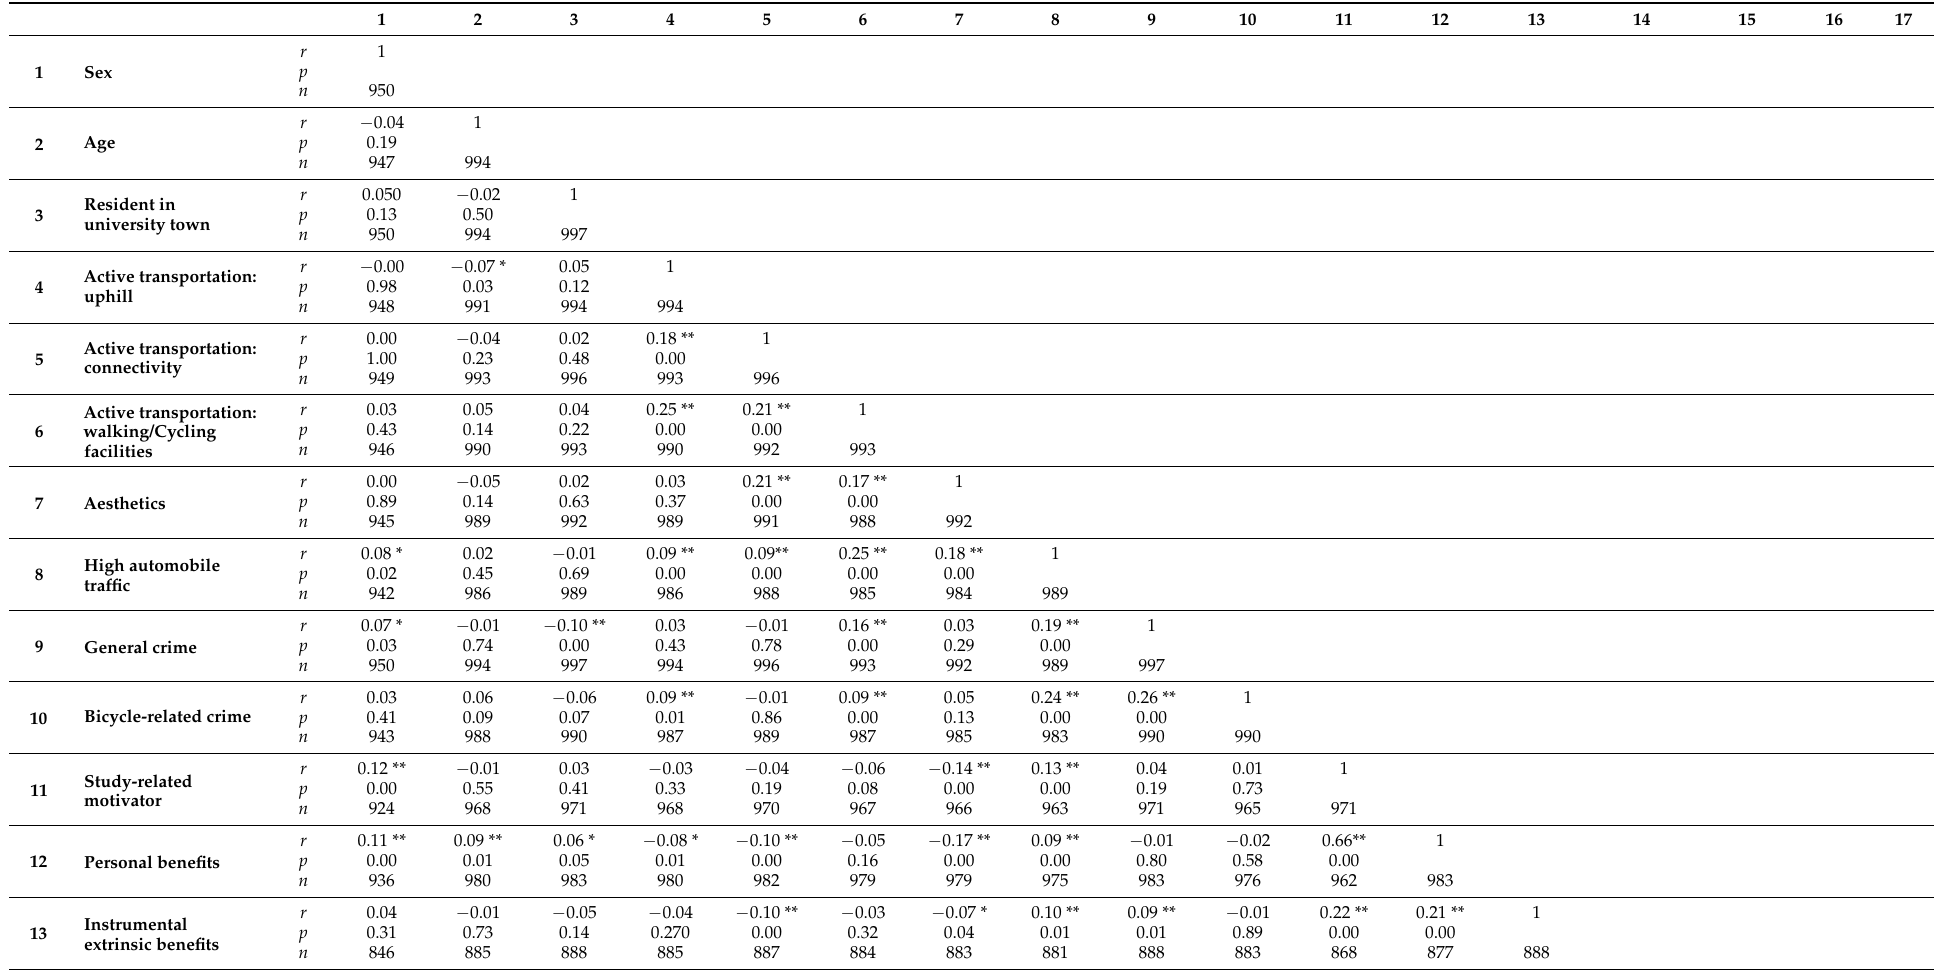
Table A9. Results (inter-item-correlation-coefficients r, and significant p -value) for the bivariate correlation between all variables of the regression